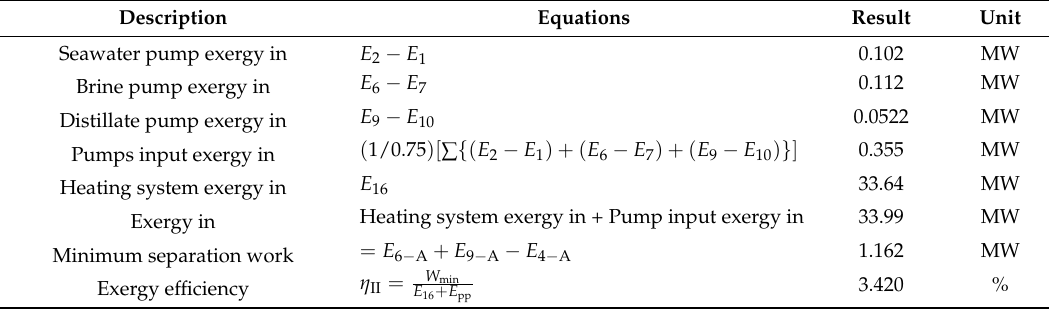
Table 6. Exergy analysis result summary for MED-TVC plant without using preheating